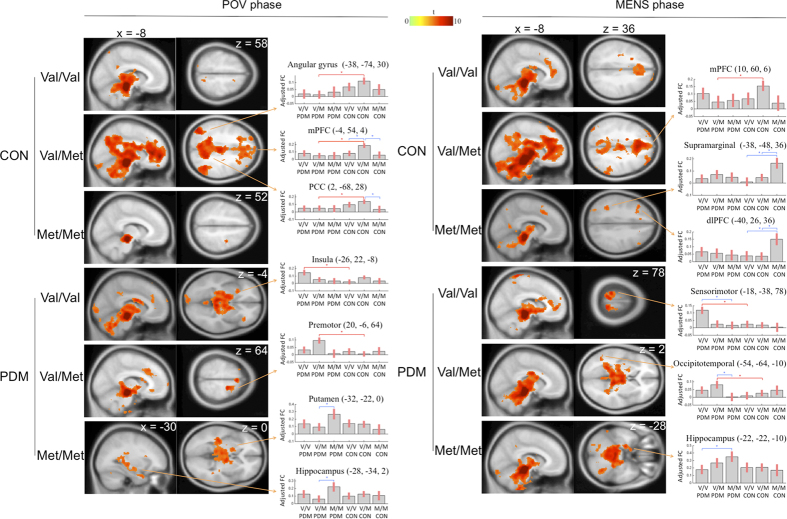
The Val66Met polymorphism of the BDNF is associated with the menstrual cycle variation in the functional expression of the descending pain modulatory system.Regions exhibit significant (FWE-corrected voxel level p < 0.05) resting-state functional connectivity with the PAG for between-group and/or between-genotype comparisons. Each region’s detail is listed in Tables 3 and 4 and Supplementary Table S3. The results are superimposed on the SPM T1 template, and the color bar represents t-scores. All figures adopt neurological orientation (left = left). The bar charts show the adjusted functional connectivity at the peak voxel of each region (coordinates in Montreal Neurological Institute space) for each genotype (V, valine; M, methionine) across the two groups (PDM, primary dysmenorrhea; CON, control) during the two phases (MENS, menstrual; POV, periovulatory). The error bar corresponds to a 90% confidence interval. *denote the contrasts that are significant in the between-group comparisons of each genotype (red) or between-genotype comparisons of each group (blue).